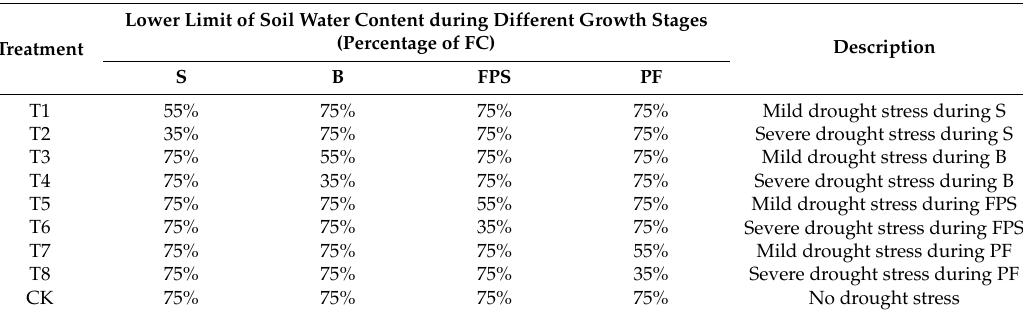
Table 3. Experimental design of water deficit during different growth